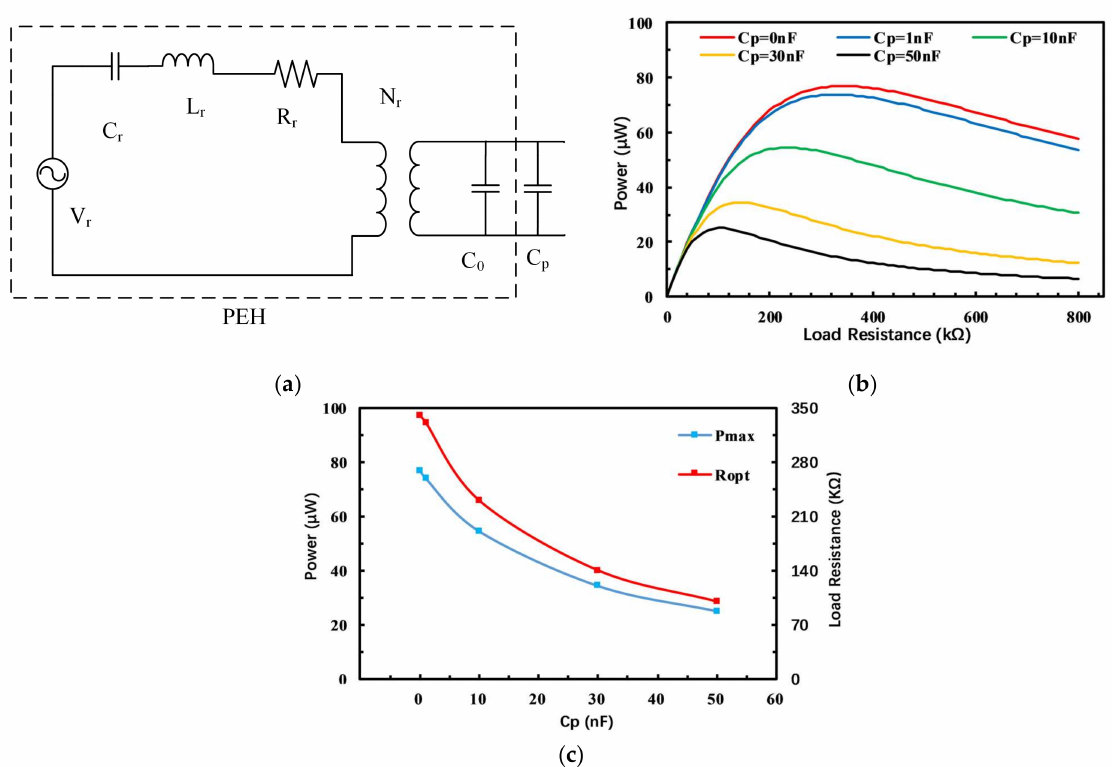
Figure 9. The influence of the parasitic capacitance on output characteristics. ( a ) The equivalent circuit model for the PEH with parasitic capacitances; ( b ) The relationship between output power and resistance for different parasitic capacitances; ( c ) The relationship between maximum output power, optimal matching resistance and parasitic